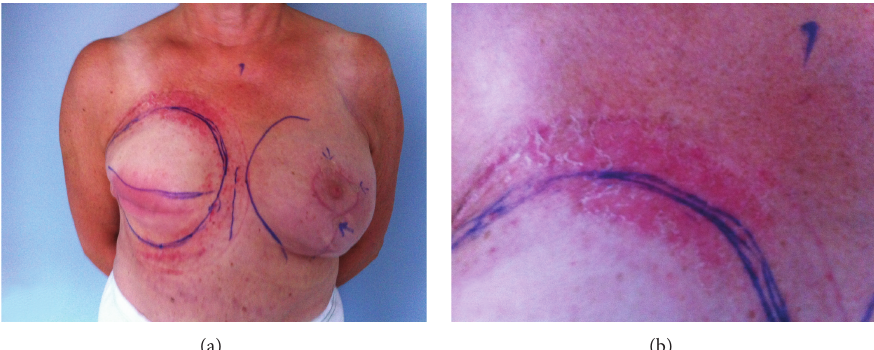
Figure 1: (a) Irritative skin rash located primarily to skin exposed to the Brava systems silicone gel cushioning. (b) Close-up of irritative rash.